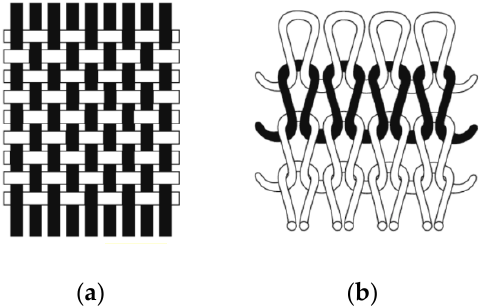
Figure 7. Fabric structure of ( a ) woven and ( b ) knitted fabrics [28].